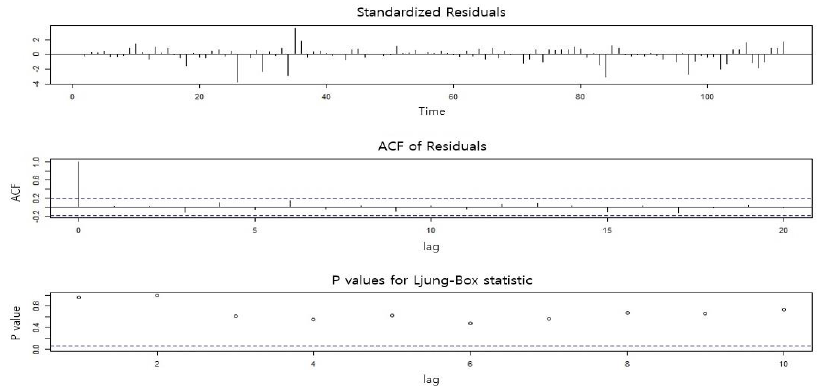
Figure 7. Fitted model for sand throughput.